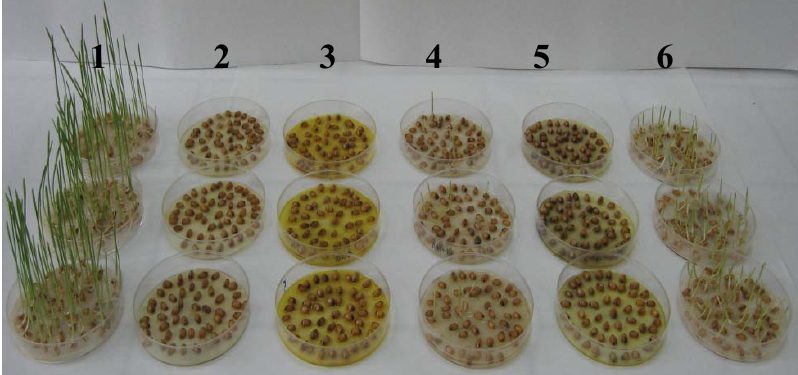
Figure 6. Effect of 4,6-dinitro- o -cresol (DNOC), 2,4-dinitrophenol (2,4-DNP) and dinocap on wheat seed